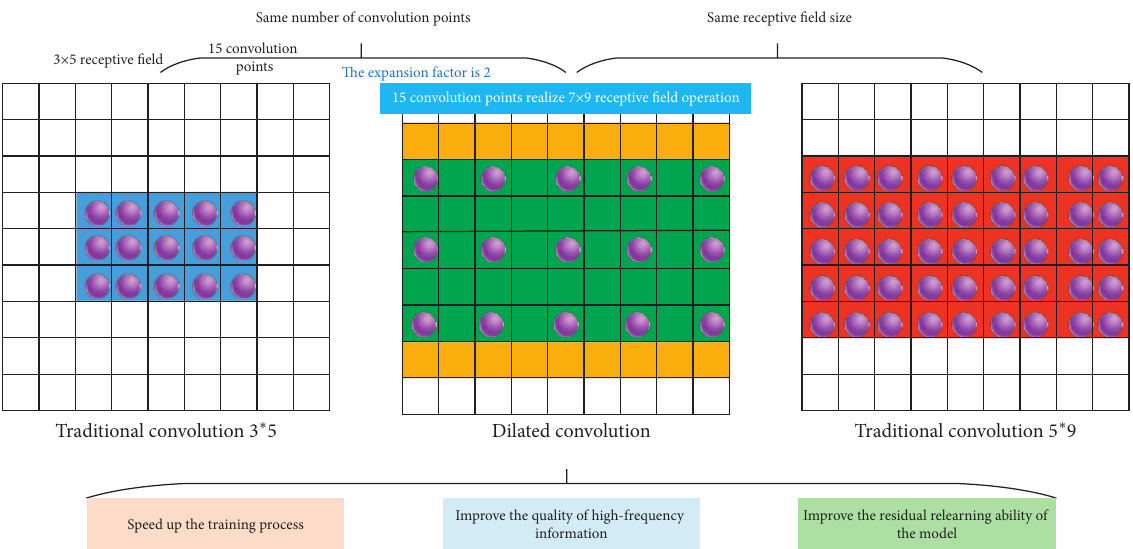
Figure 2: Comparison of dilated convolution and traditional